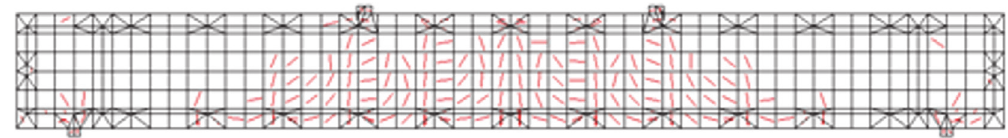
Figure 13: Typical map cracks in flexure region of beams B1–B6 (VecTor2